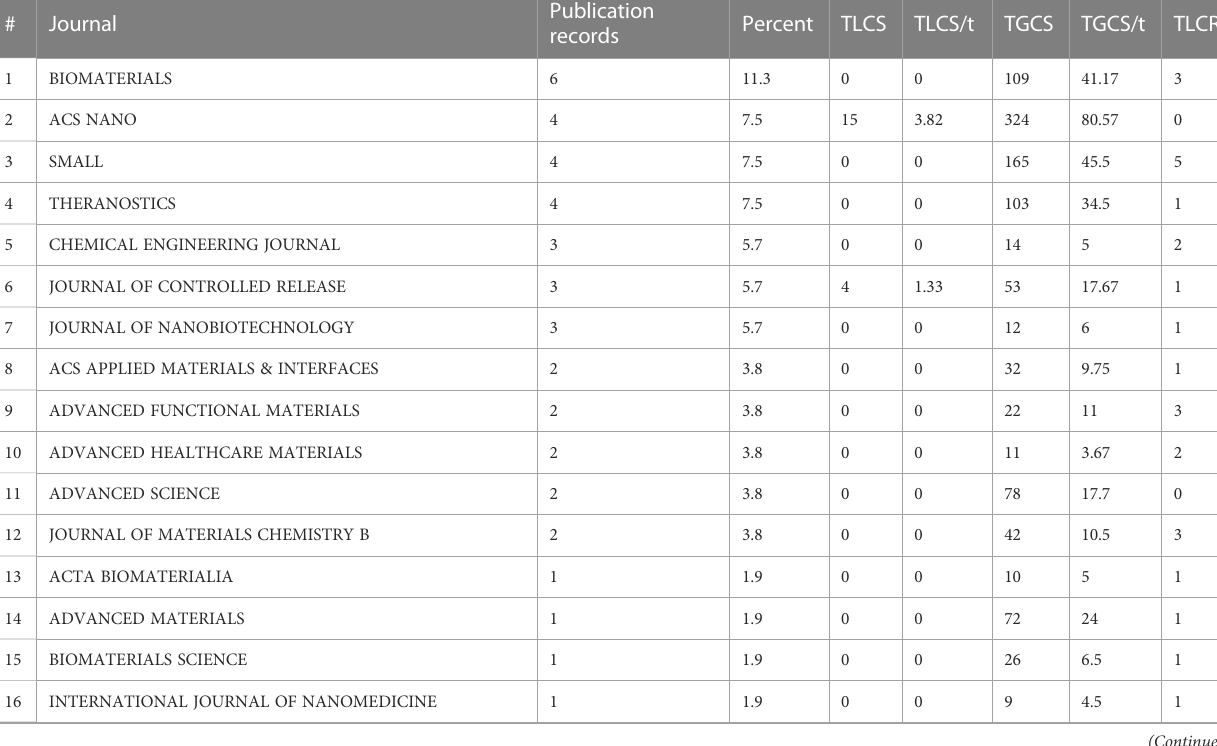
TABLE 3 Documents on nanoparticles involved in ferroptosis and cancer